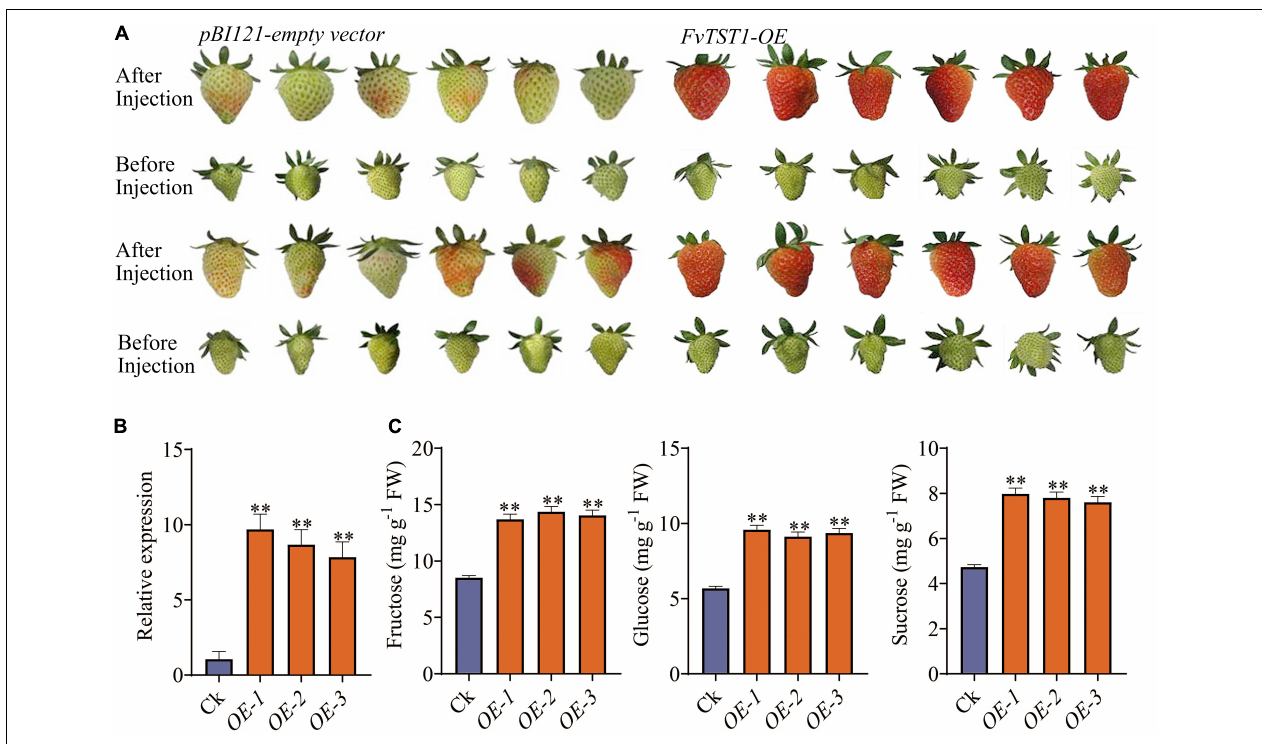
FIGURE 4 | Transient expression of FvTST1 in strawberry fruit. (A) Phenotypes of FvTST1- overexpressed strawberry fruit. (B) qRT PCR analyses of FvTST1 -overexpressed fruit and control. (C) Sugar content (fructose, glucose, and sucrose) in FvTST1 -overexpressed fruits. The values represent mean ± standard deviation of three biological replicates. The SPSS software (v19.0) was used for one-way analysis of variance (ANOVA) ( ∗∗ p <